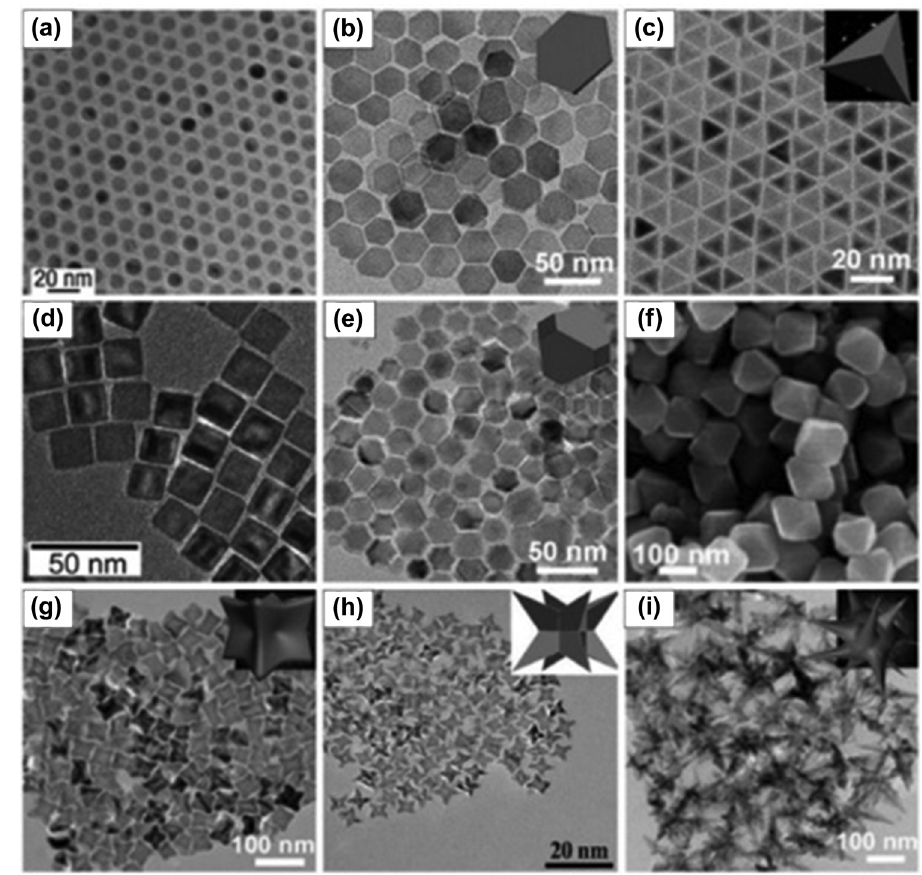
Figure 10: Example morphologies of 0D IO NPs synthesized from iron oleate and sodium oleate ( biomass wastes ) : ( a ) nanospheres, ( b ) plates, ( c ) tetrahedrons, ( d ) cubes, ( e ) truncated octahedrons, ( f ) octahedrons, ( g ) concaves, ( h ) octapods, and ( i ) multi branches [ 405 ]